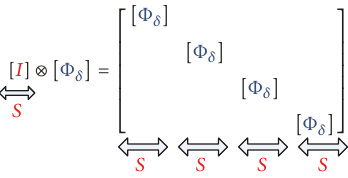
Figure 1: The diagram of the joint measurement matrix in Duarte’s method.